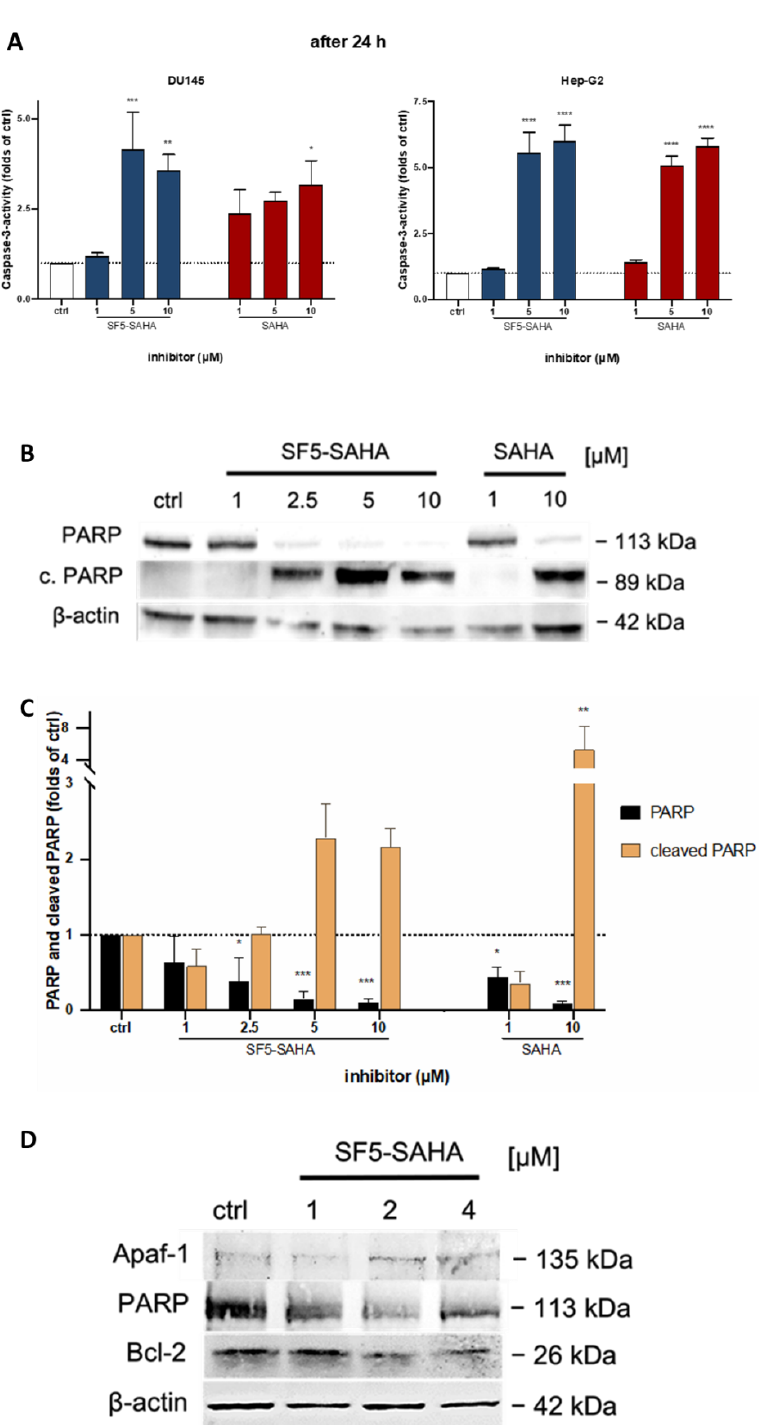
Figure 3. Apoptosis induction by SF5-SAHA. ( A ) Caspase-3 induction in DU145 or Hep-G2 cells after 24 h treatment with SF5-SAHA and SAHA. Means ± SEM of n = 3 independent experiments. ( B ) Representative Western blot out of n = 3 experiments, showing changes in the expression of PARP and PARP after cleavage (cl. PARP) in DU145 cells after 24 h treatment with test compounds. ( C ) From these Western blots gray intensities, of PARP and cleaved PARP specific bands were quantified adjusted to protein loading and normalized to untreated controls. ( D ) Representative Western blot out of n = 3 experiments, showing changes in the expression of Apaf-1, PARP, and Bcl-2 in Hep-G2 cells after 24 h treatment with SF5-SAHA. Data are given as means ± SEM of n = 3 independent experiments. * p ≤ 0.05, ** p ≤ 0.005, *** p ≤ 0.0005, **** p ≤ 0.0001; 2-way ANOVA Dunnett’s post-hoc test.